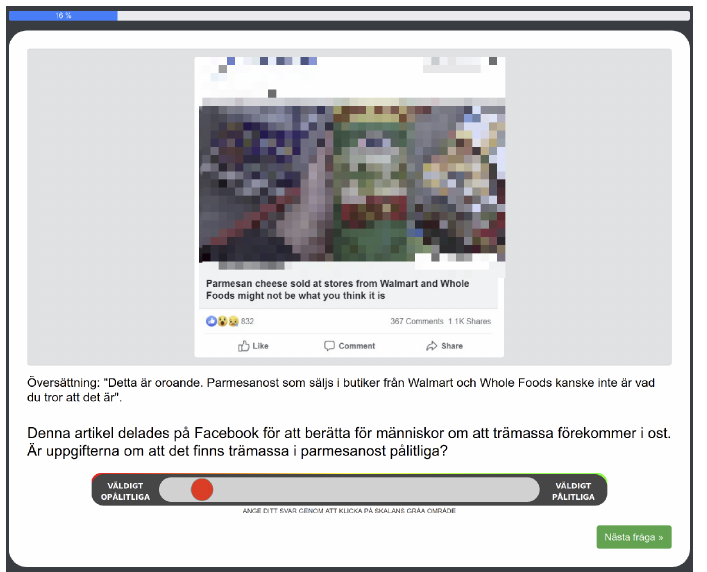
Figure 1. Screenshot of an experimental item with track bar allowing participants to provide their credibility assessment